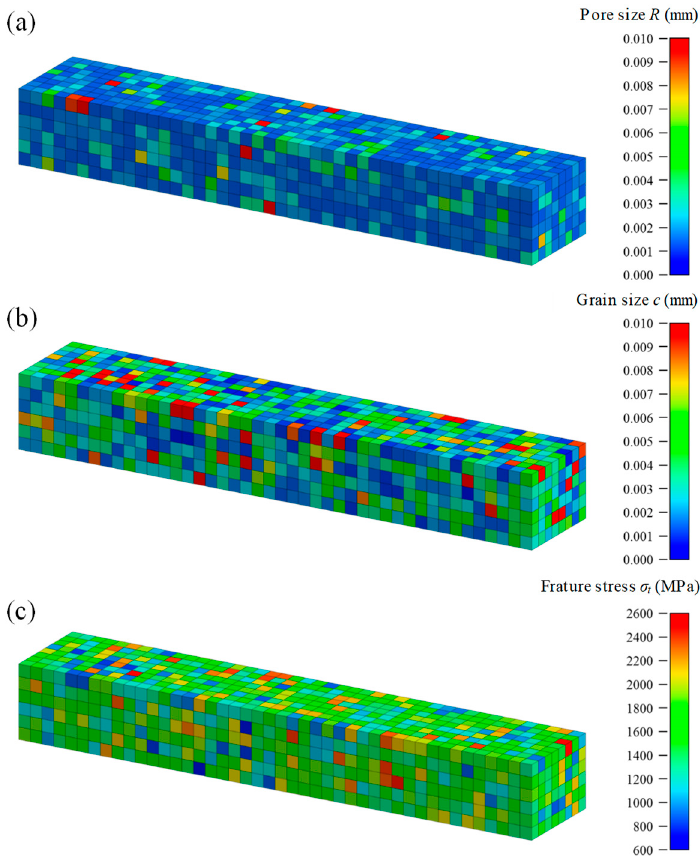
Figure 5. Distributions of microstructure data in three specimens arbitrarily extracted from four-point bending test models. The contour map shows: ( a ) pore size R ; ( b ) grain size c ; and ( c ) fracture stress σ t .